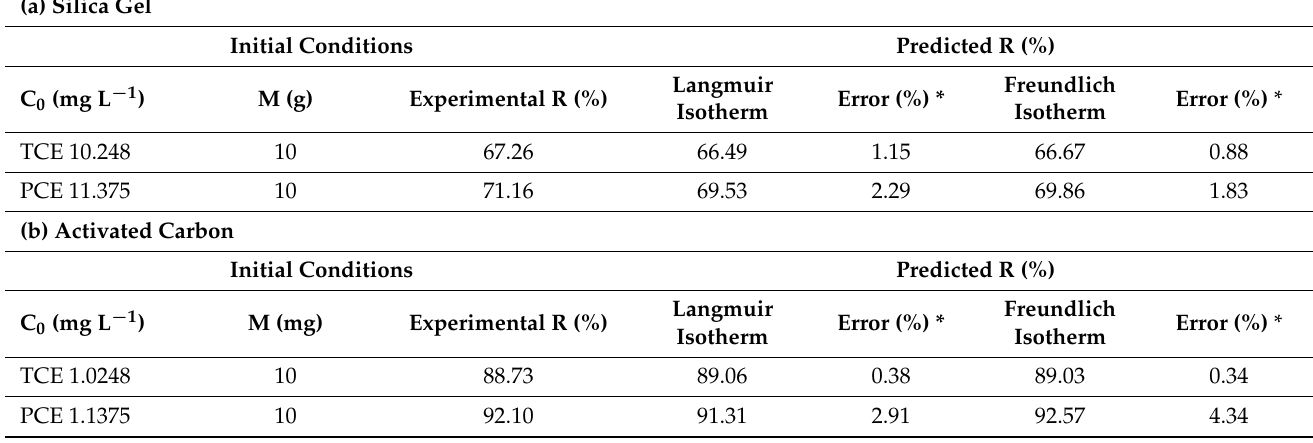
Table 10. Comparison of removal efficiency (R(%)) predicted by Langmuir and Freundlich isotherms with mass balance to experimental data points obtained from the adsorption of TCE and PCE onto (a) silica gel and (b) activated